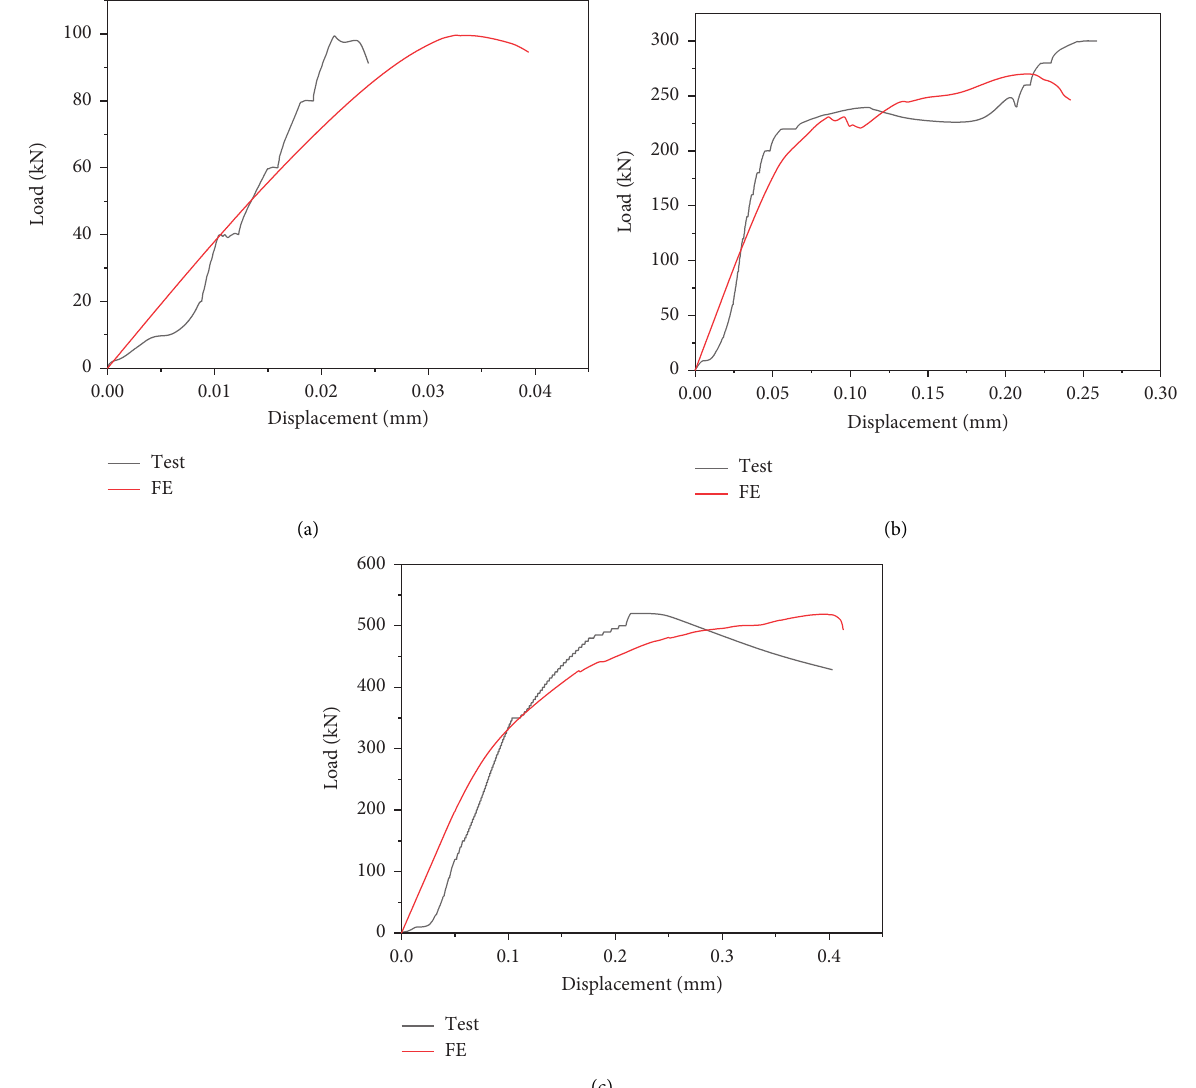
Figure 21: Load-displacement curves of experiment and finite element results. (a) Type 1. (b) Type 2. (c) Type 3.